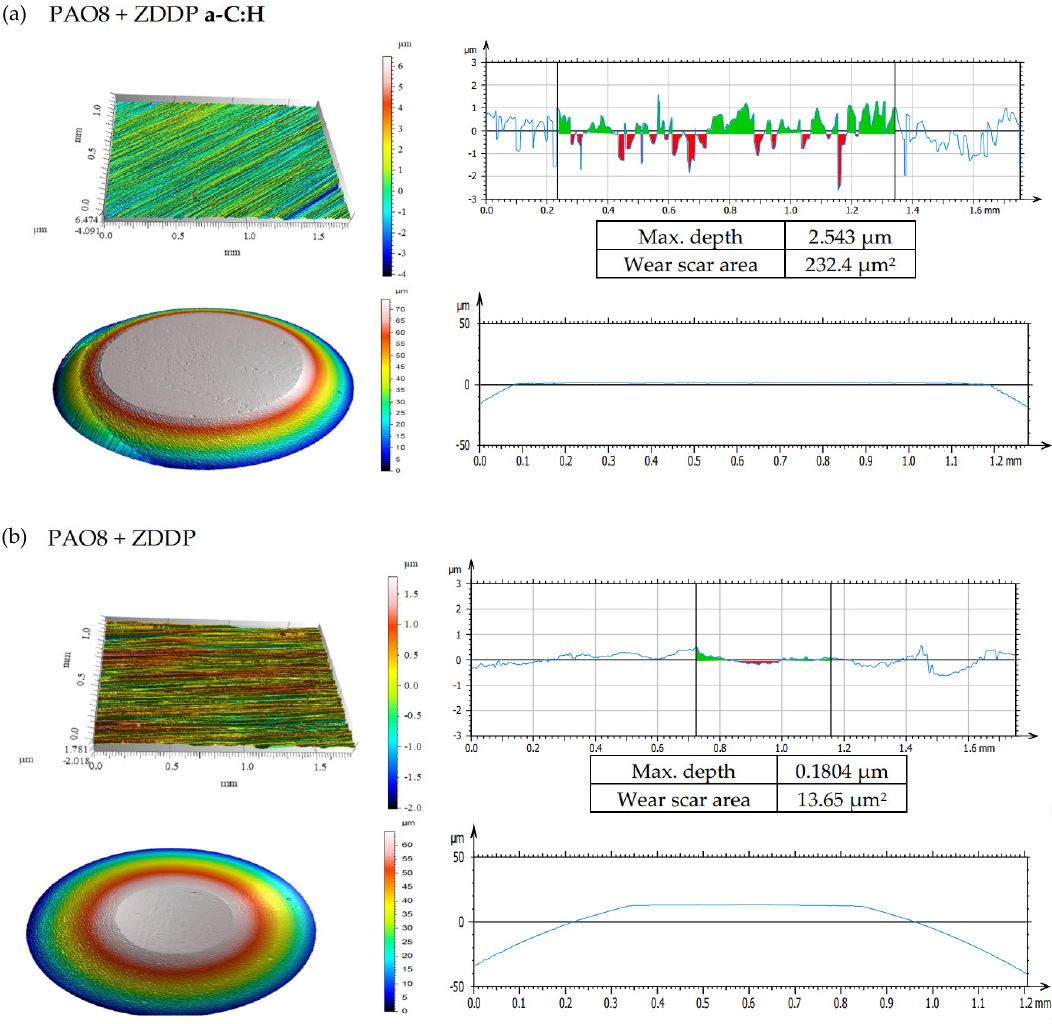
Figure 7. Isometric views and primary profiles of the discs and balls after the tribological tests of PAO8 + ZDDP on TRB 3 tribotester equipped with ( a ) disc coated by a-C:H and ( b ) uncoated disc. ZDDP, zinc dithiophosphate.